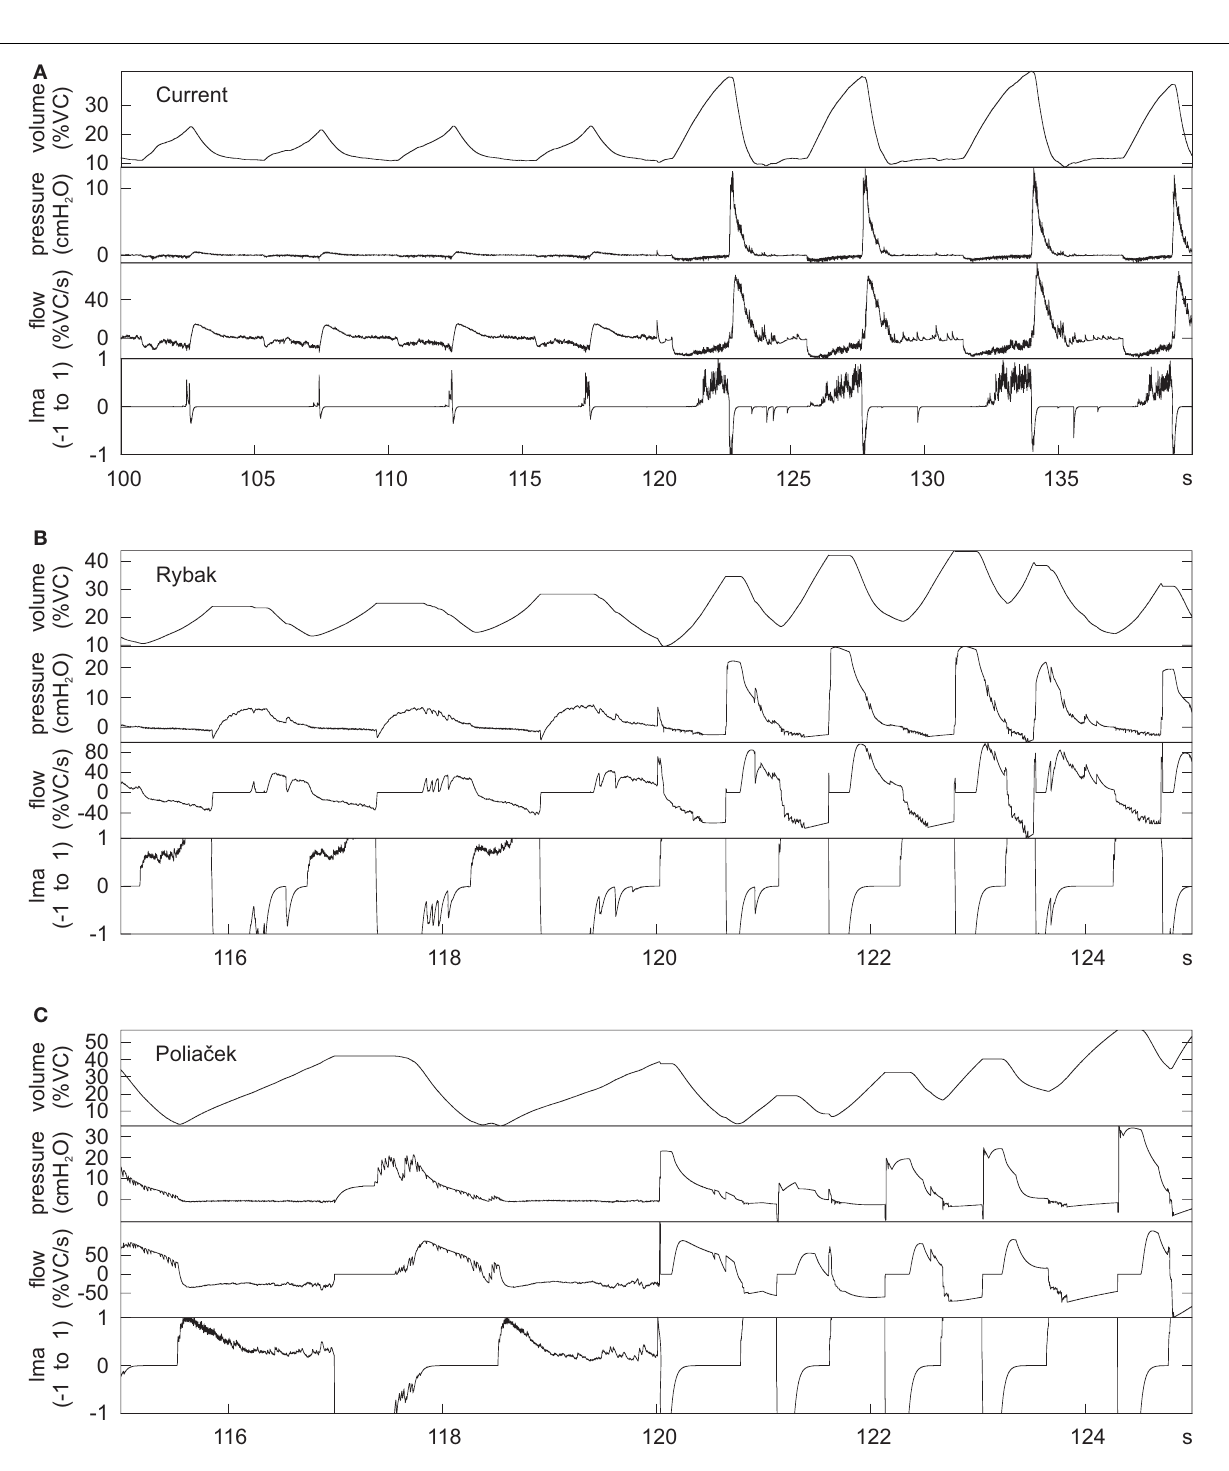
FIGURE 8 | Outputs of the mechanical model when linked to the current network model (A) and the networks in (B) (Rybak et al., 2008) and (C) (Poliaˇcek et al., 2011). The earlier networks were designed without a mechanical model, but were connected to the current mechanical model to generate these plots.The plots are lung volume, alveolar pressure, tracheal